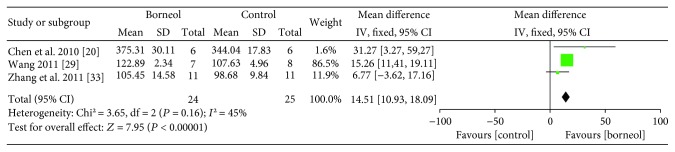
The forest plots: the borneol group versus the control group on SOD activity under pathological conditions.